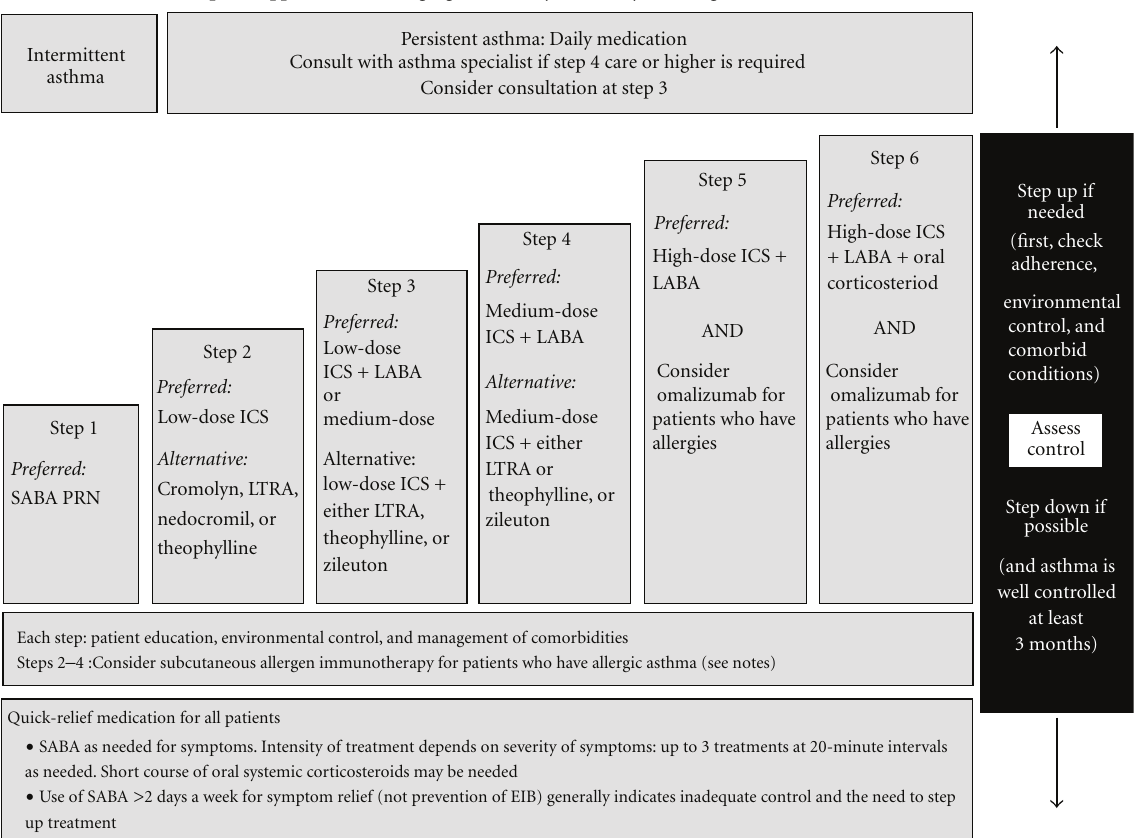
Figure 4: Guideline recommended stepwise approach to managing asthma in adolescents and adults. ICS: inhaled corticosteroid, EIB: exercise induced bronchospasm, LABA: long-acting β 2 -agonist, LTRA: leukotriene receptor antagonist, and SABA: short-acting β 2 -agonist, reproduced from